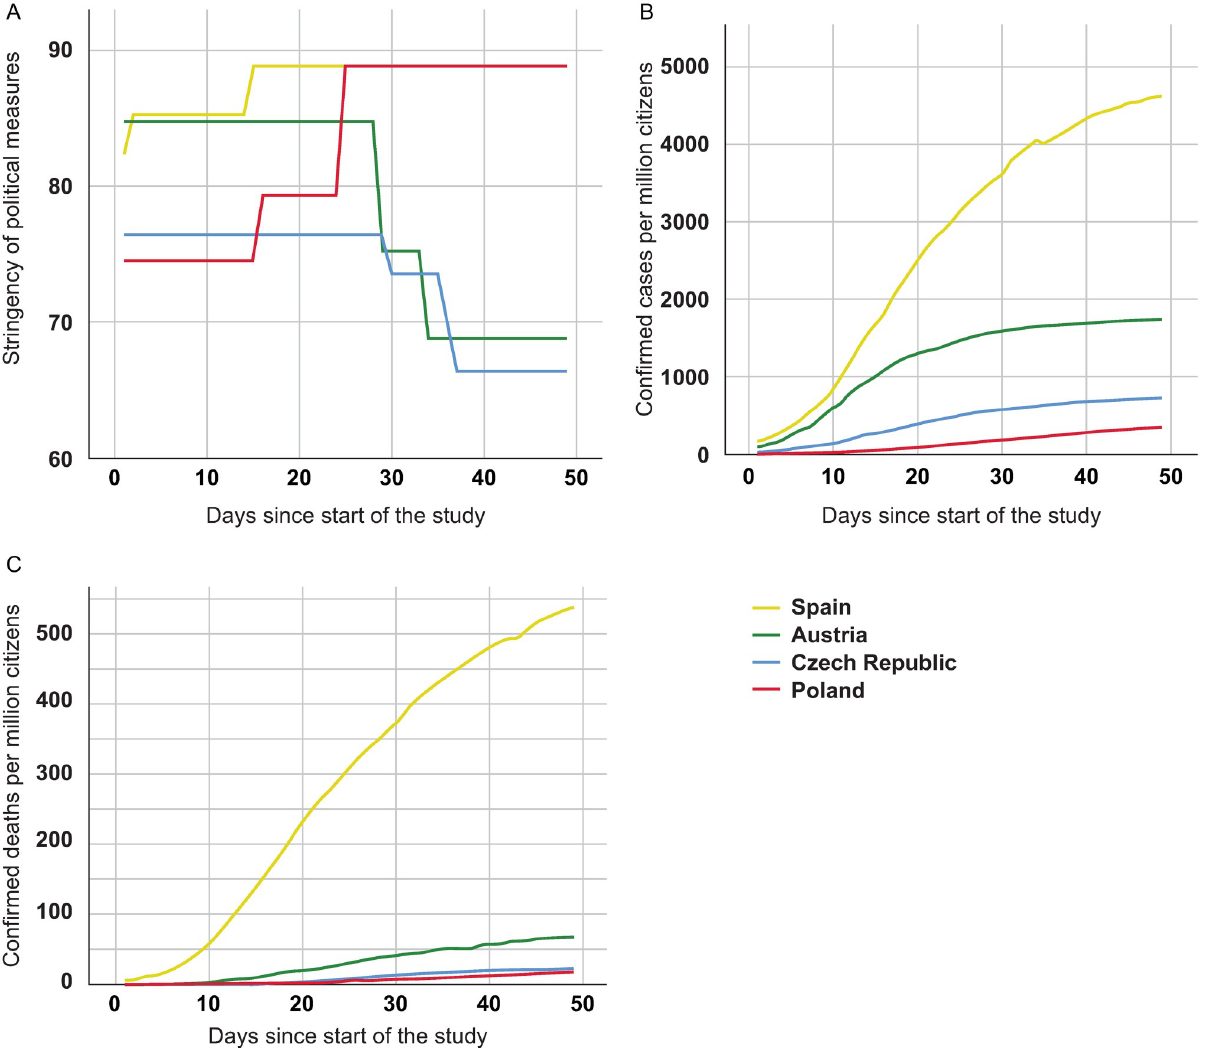
Fig 1. Spread of COVID-19 and governmental reactions. (A) Severity of governmental measures in response to the pandemic summarized as a stringency index (SI) [28], (B) confirmed cases and (C) deaths per million citizens caused by COVID-19 over the course of the study for Spain (yellow), Austria (green), Poland (red) and Czech Republic (blue). Source: Hale et al. [50]; Eurostat [51].